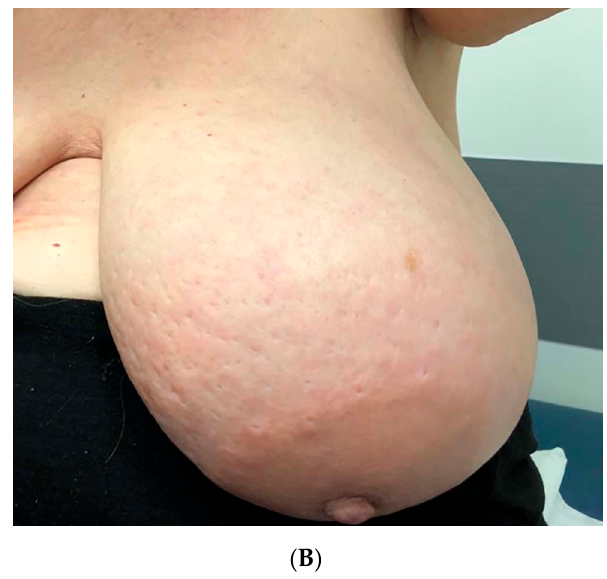
Figure 1. ( A ). Clinical appearance of the right breast (increased volume, intense redness, “peau d’ orange”). ( B ). Clinical appearance of the left breast (increased volume, moderate redness, “peau d’ orange”).